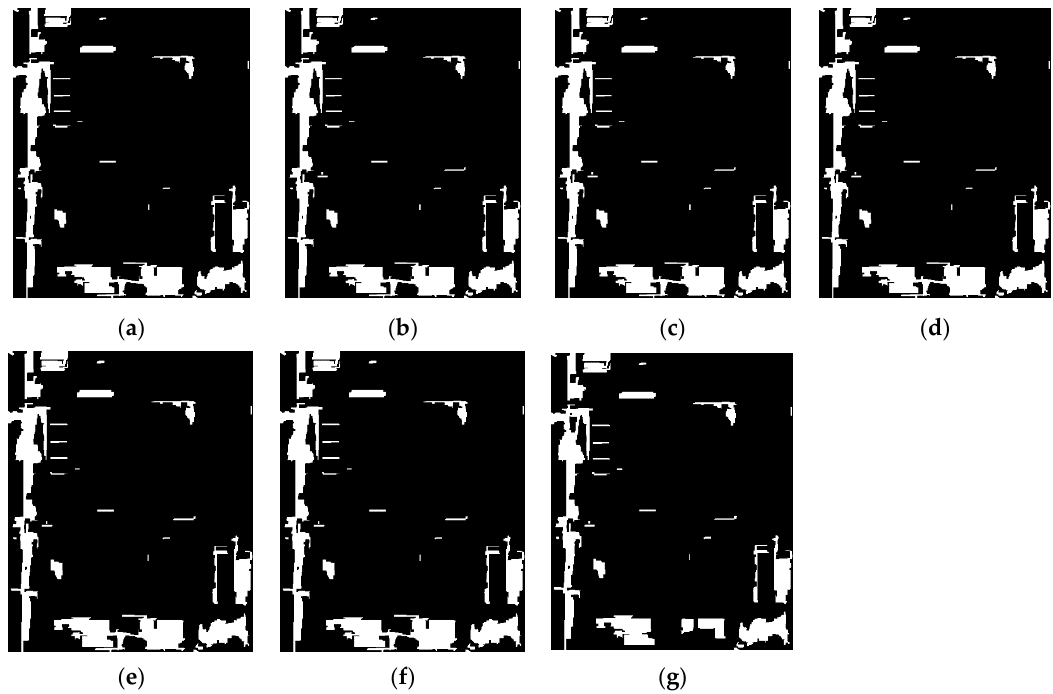
Figure 11. CD maps for a value of the thresholds of ( a ) 0.6; ( b ) 0.65; ( c ) 0.7; ( d ) 0.75; ( e ) 0.8; ( f ) 0.85 and ( g ) 0.9 using the first segmentation map for Q = 64.